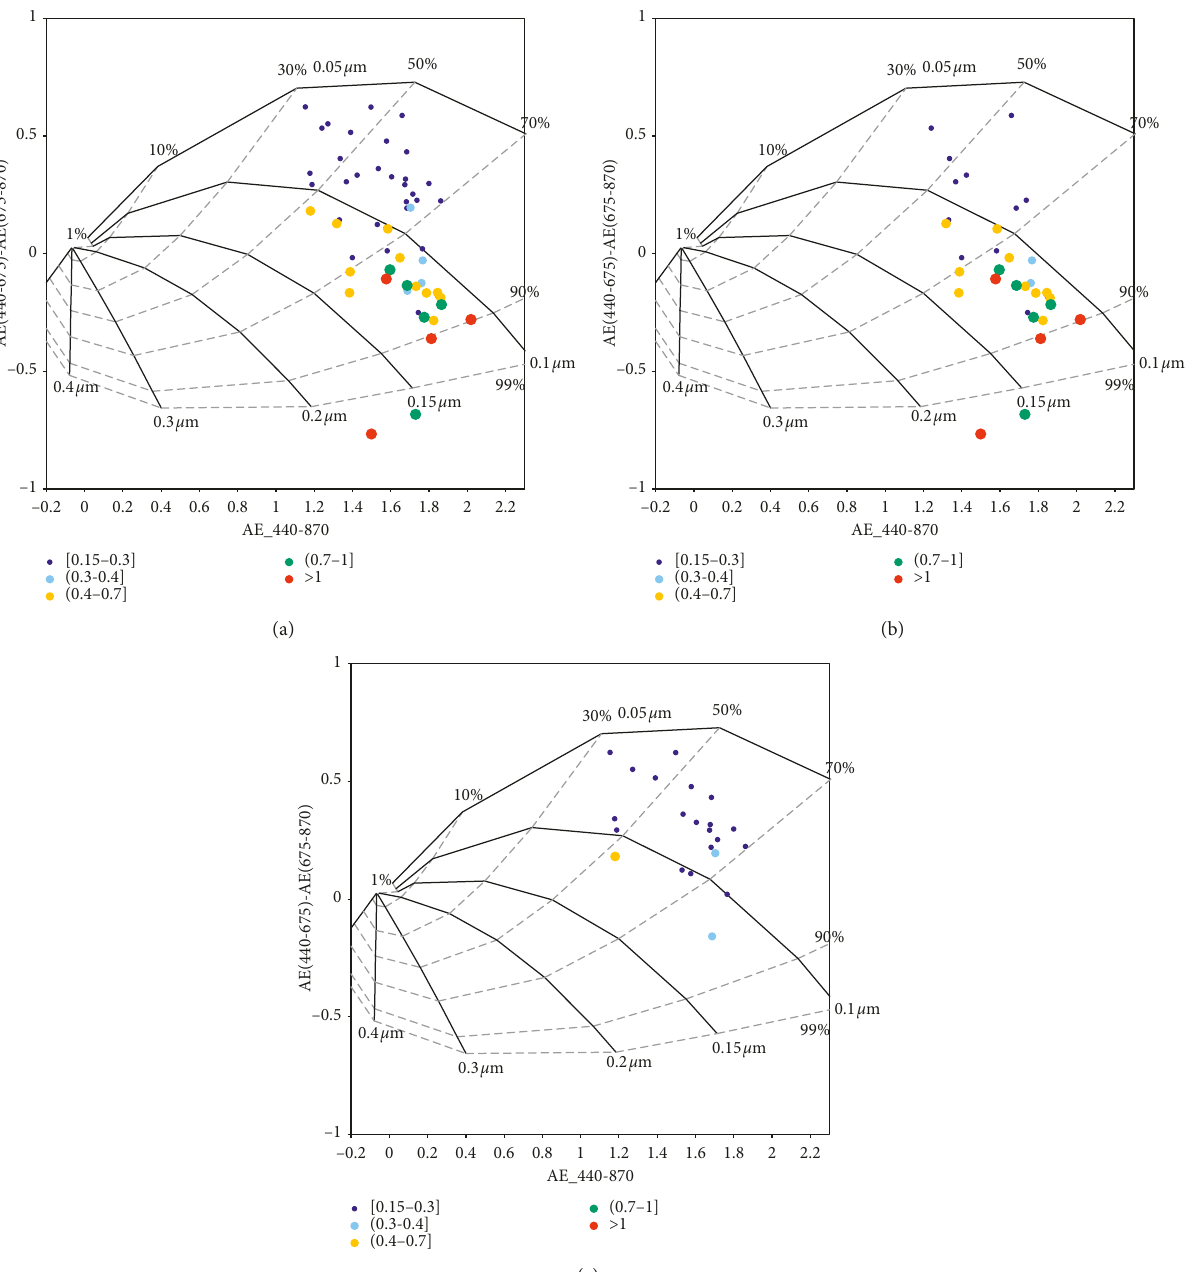
Figure 7: ˚Angstr¨om exponent difference as a function of the ˚Angstr¨om exponent and AOD (colour code) for CEILAP-BA. Only data with AOD500nm greater than 0.15 are included: (a) selected days; (b) selected days during biomass-burning months; and (c) selected days in the remaining